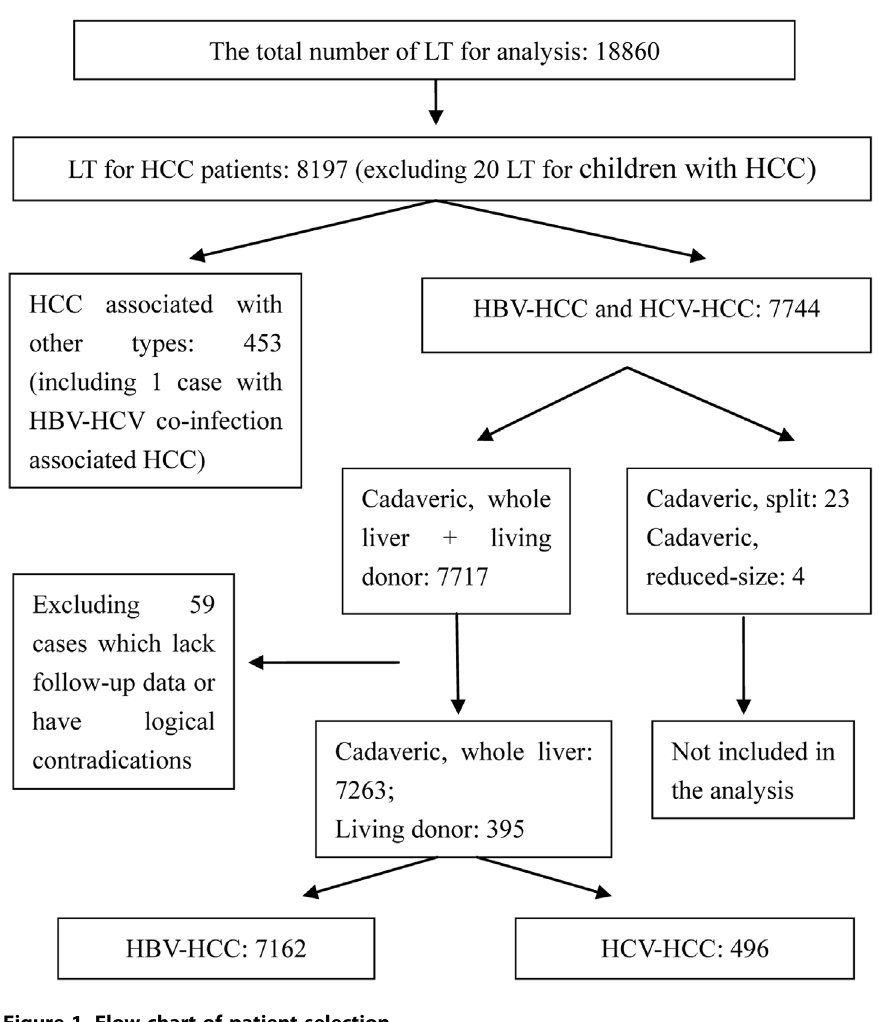
Figure 1. Flow chart of patient selection.